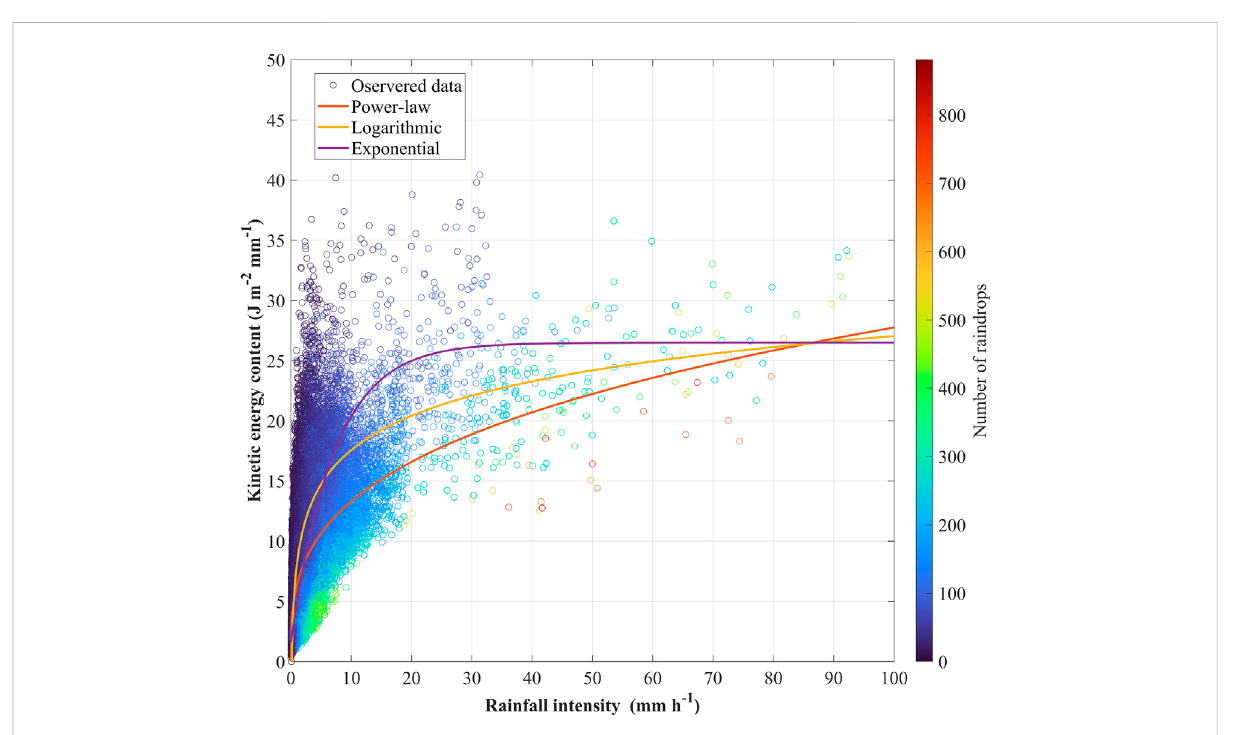
FIGURE 5 Scatter plotsof 151,852 KE con – I r points wereanalyzed and described by three differentmodels, i.e., thepower-law (Eq. 12), logarithmic (Eq. 13), and exponential (Eq. 14)